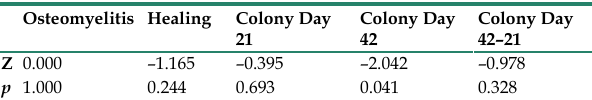
Table 1 : Statistical comparison of healing and the number of colonies between the two groups.